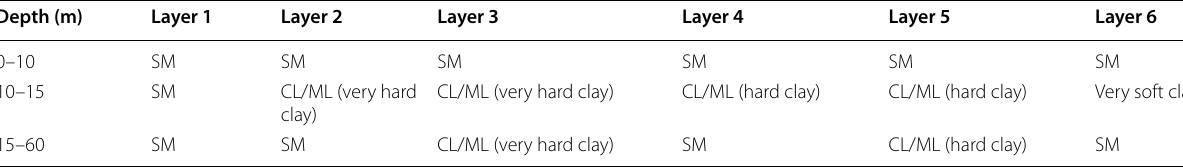
Table 11 The cross-sectional features of the different substructure soil layers.